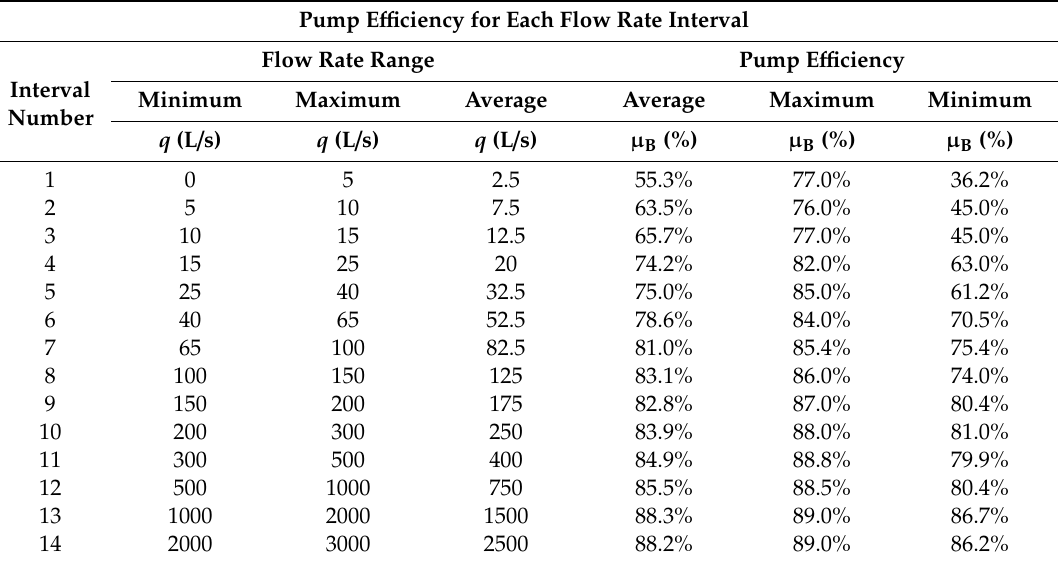
Table 1. Elaboration of the adjusted curves of the pump e ffi ciency versus the flow rate.